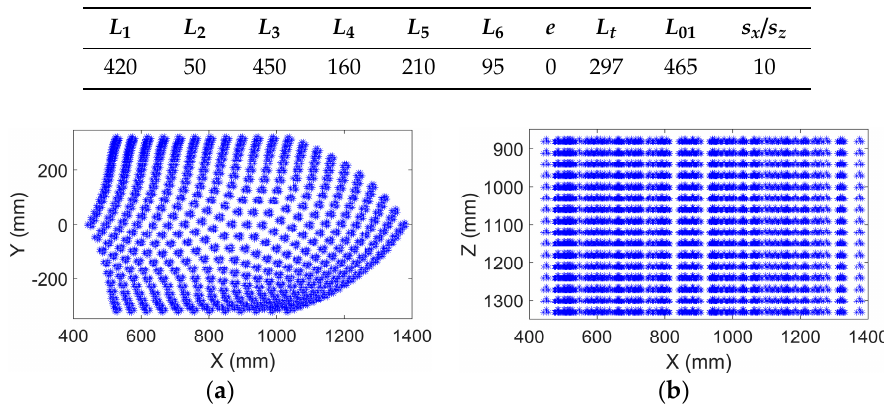
Table 1. Robot manipulator structure parameters (mm).